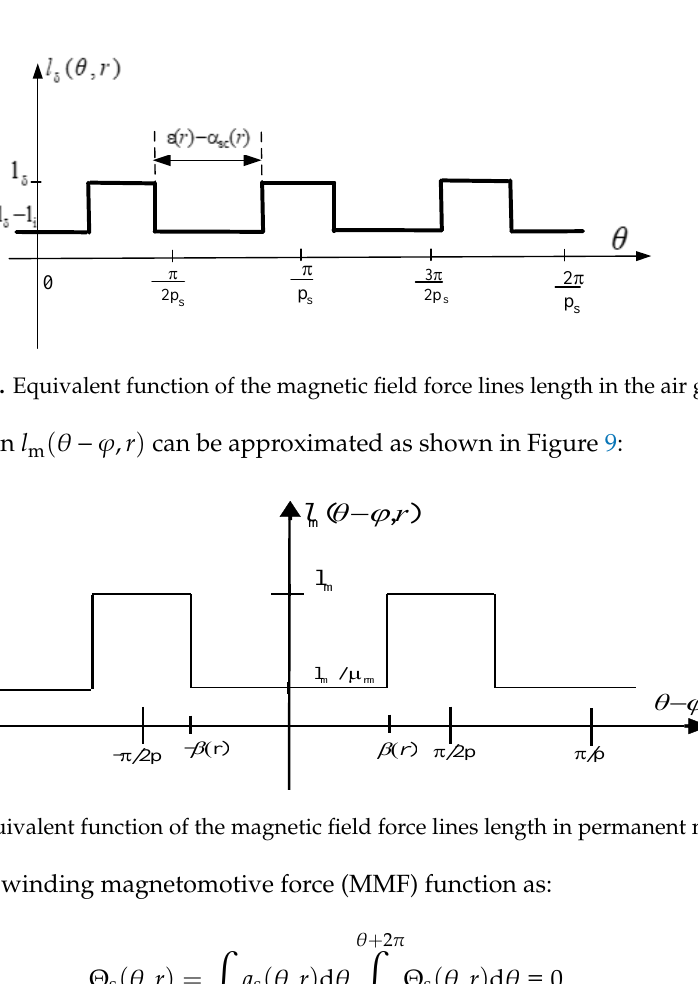
shown in Figure 8.